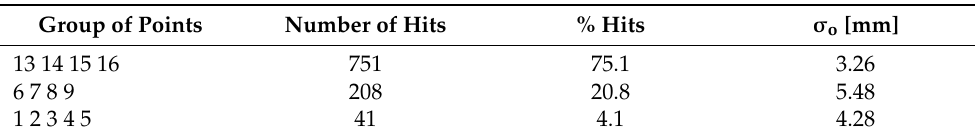
Table 6. Results of identification of the stability of reference system by the simulated annealing method—test object